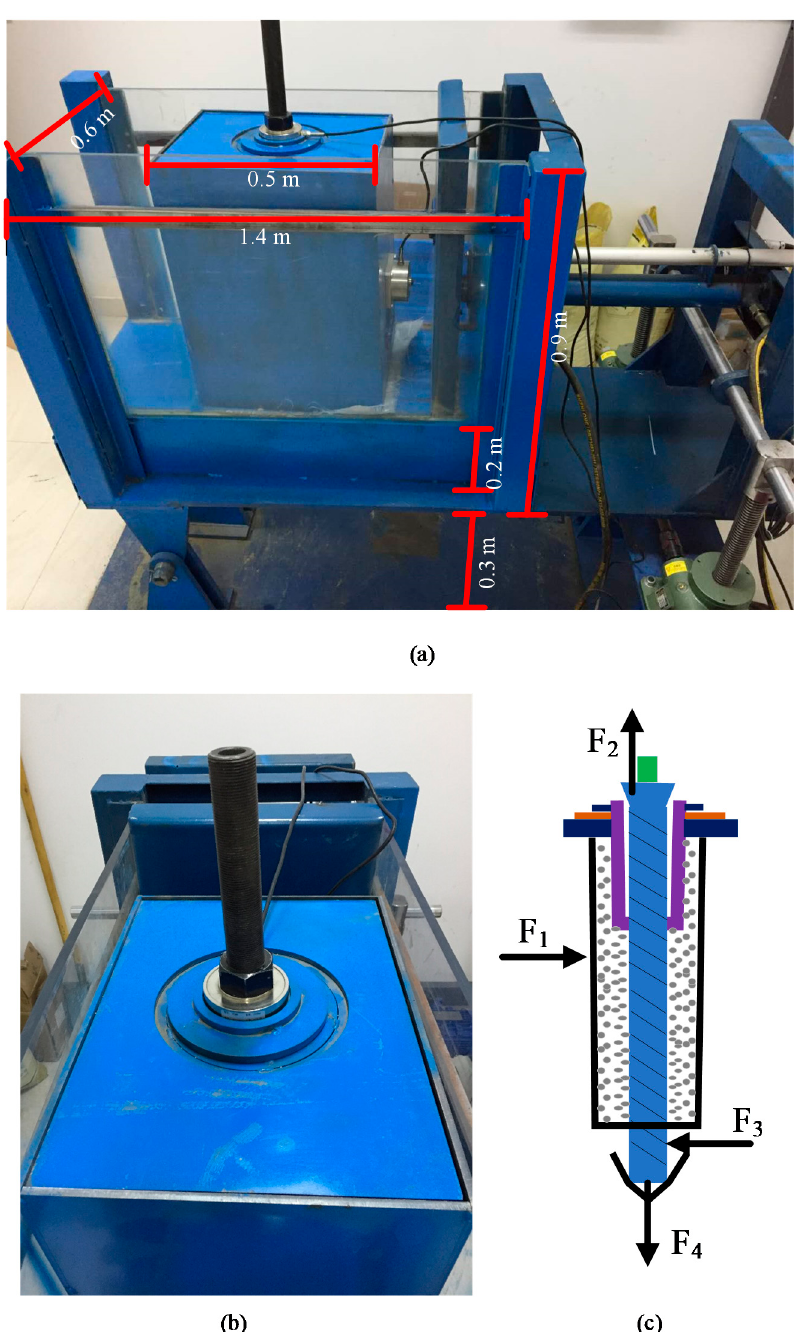
Figure 2. ( a , b ) are lateral view and top view photographs of landslide experiment system. ( c ) is the force analysis diagram of flexible device; F 1 represents the thrust applied to the rubber tube, F 2 denotes the upward axial tension to the sleeve, F 3 represents the lateral resistance of the anchor cable from the anchorage, F 4 denotes the downward binding force from the anchorage to the anchor cable. Table 2. Properties of backfill material.